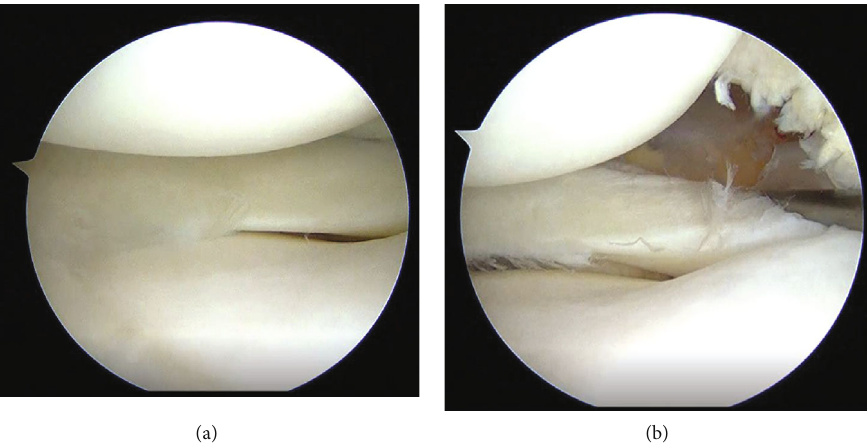
Figure 4: (a) and (b) Arthroscopic fi ndings after resection of the accessory meniscus show that thickness and shape of the resected meniscus are similar to those of the normal